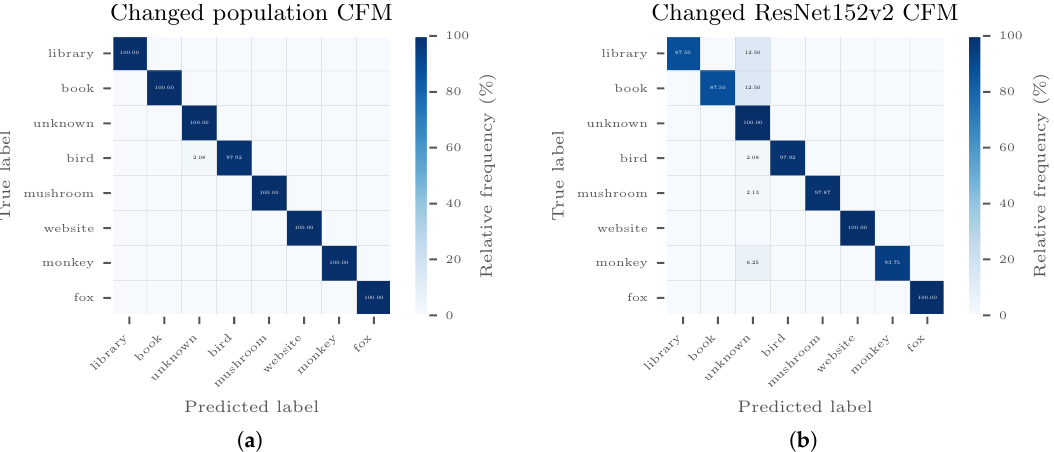
Figure A3. The human population CFM ( a ) and ResNet CFM ( b ) after applying CRT to the dataset D (cid:48) , which was derived from the ILSVRC2012